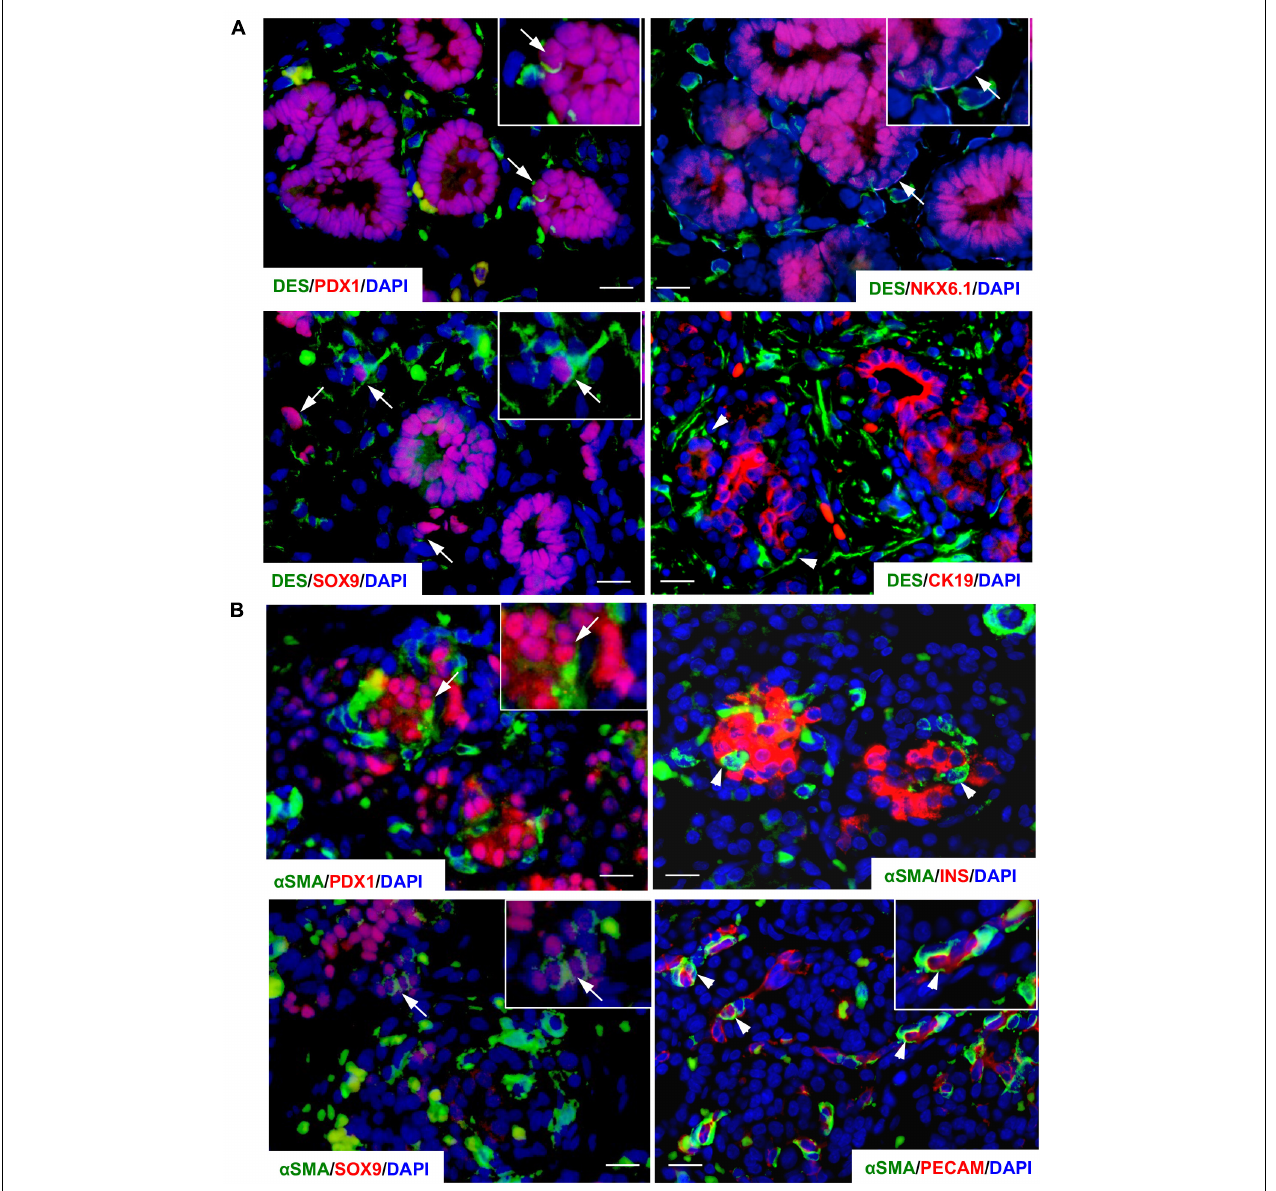
FIGURE 2 | Co-localization of PaSC markers in the developing human fetal pancreas. Double immunofluorescence staining of PaSC markers (A) desmin (DES, green) with PDX1, SOX9, NKX6-1 or CK19 (red) in a 9-week human fetal pancreas; (B) α SMA (green) with PDX1, SOX9, insulin (INS) or PECAM (red) in a 20–21-week human fetal pancreas with the nuclear stain DAPI (blue). Scale bar: 25 µ m. Arrows indicate co-stained cells and arrowheads identify single stained cells. Magnified images are shown in